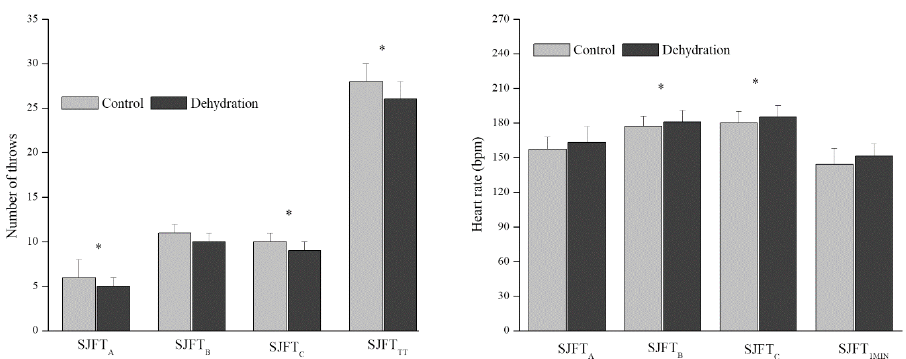
Figure 2. SJFT performance (number of throws) and heart rate in the control and dehydration conditions. A = First set (15 s), B = Second set (30 s) and C = Third set (30 s); TT = Total throw; * p < 0.05.